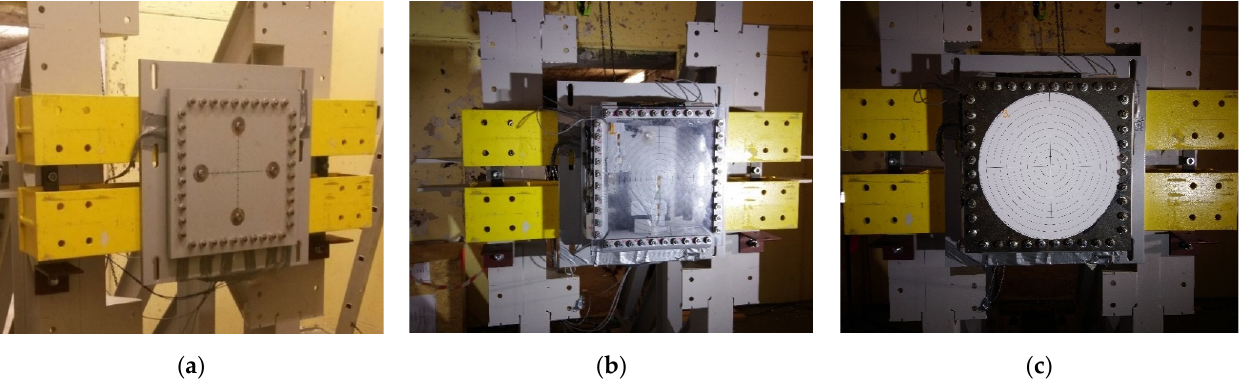
Figure 5. Parts of experimental setup: ( a ) load sensors; ( b ) plexiglass plate with mounted tensiometers; ( c ) steel rigid plate.